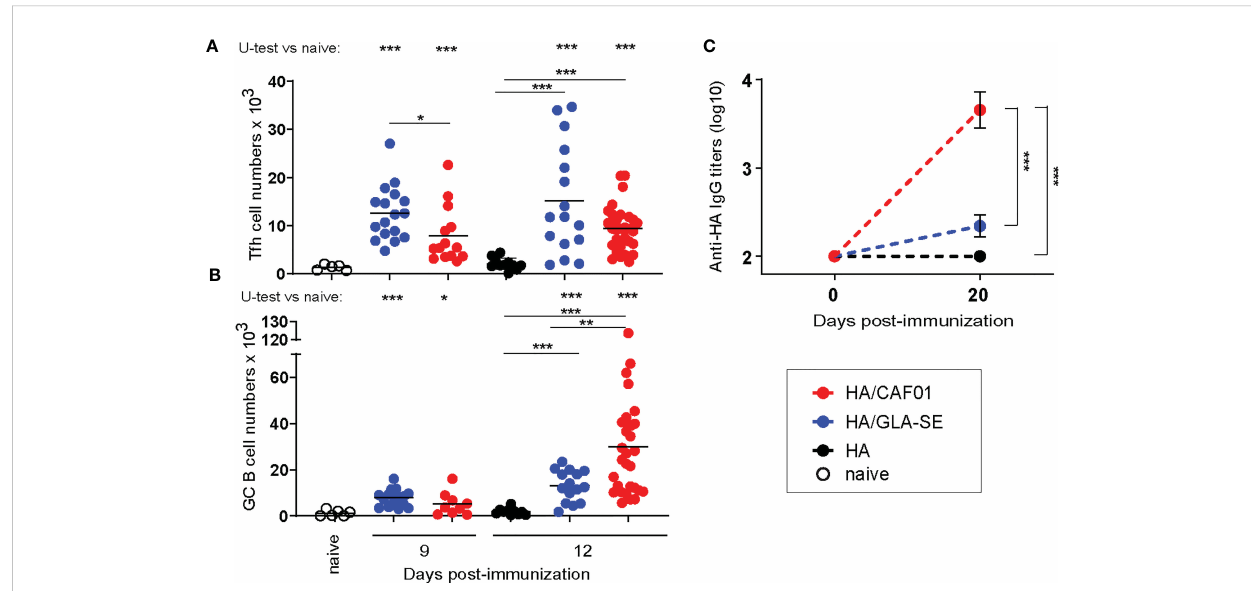
FIGURE 1 Neonatal primary Tfh, germinal center B cell, and antibody responses to HA/CAF01 or HA/GLA-SE. Groups of neonatal CB6F1 mice were immunized s.c. with HA formulated with CAF01 or GLA-SE. Age-matched mice receiving HA/PBS or non-injected (naïve) were used as control. (A, B) Draining LNs were harvested at the indicated time points after immunization, and samples were analyzed by fl ow cytometry. Graphs report the numbers of (A) T follicular helper (Tfh) cells and (B) Germinal Center (GC) B cells. Dots show values per individual mouse, whereas black lines indicate means. (C) HA-speci fi c IgG antibody titers in sera collected before (day 0) and 3 weeks post-immunization (day 20). Values represent mean logarithmic titers (log 10) of fi ve to eight mice per group ± SEM. (A-C) Data were pooled from at least two independent experiments per time point. Statistical analysis were performed using the Mann-Whitney U test: *P<0.05, **P<0.01,